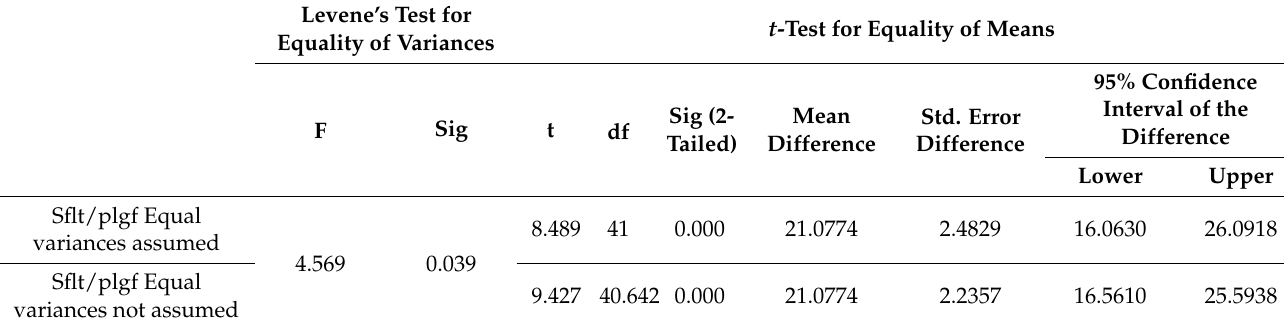
Figure 1. Distribution of preeclampsia. Table 1. Independent t -test for moderate PE and Table 4. Correlation between proteinuria and values of sFlt-1/PlGF.